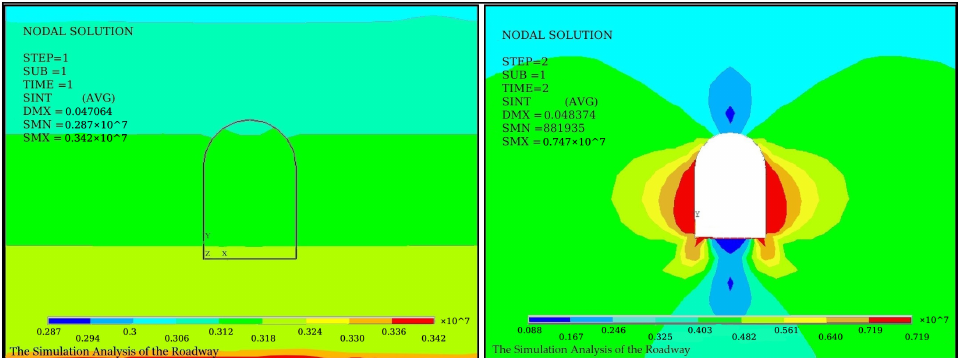
Figure 5. Diagram of stress fields before and after